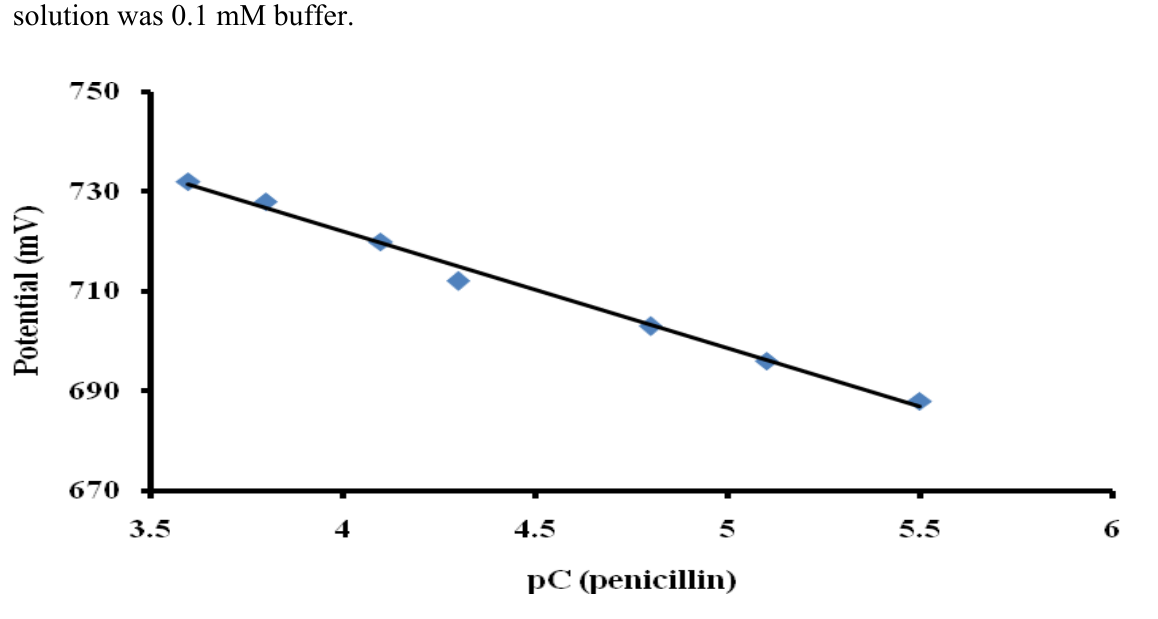
Figure 8. Plot of potential versus logarithmic concentration of penicillin obtained with the PTy-PNCnase biosensor. Film formation conditions were as for Figure 6 and measurement solution was 0.1 mM